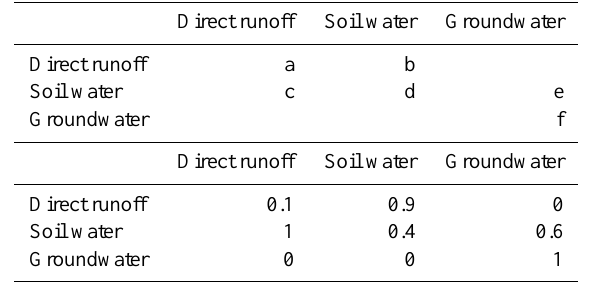
Table 2. Example square matrix for the Thames PERSiST applica- tion. The upper square matrix corresponds to the hydrological re- sponse unit shown in Fig. 2 (upper). The lower square matrix con- tains the values used in the simulations presented here.